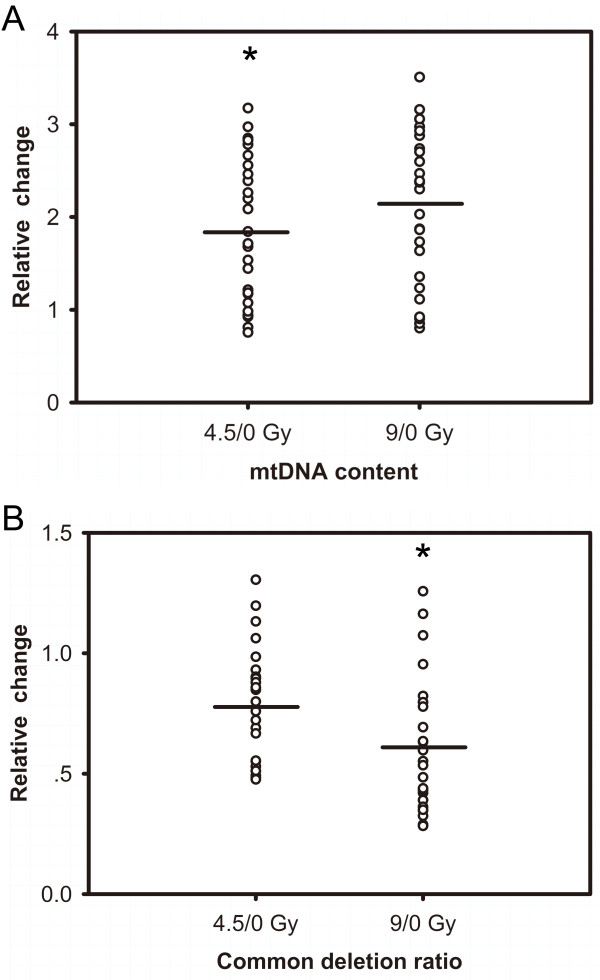
Relative change of mtDNA content (A) and CD ratio (B) from patients' PBLs (n = 26) after different dose of total body irradiation therapy. Significant difference was observed in relative mtDNA (*P = 0.041) and CD (*P < 0.001) change of every patient when comparing 9 Gy vs. 4.5 Gy exposure. A circle represents mean value of relative change level from each patient undergoing irradiation compared to their basal levels. The lines connect the mean values of relative change level from all cases.